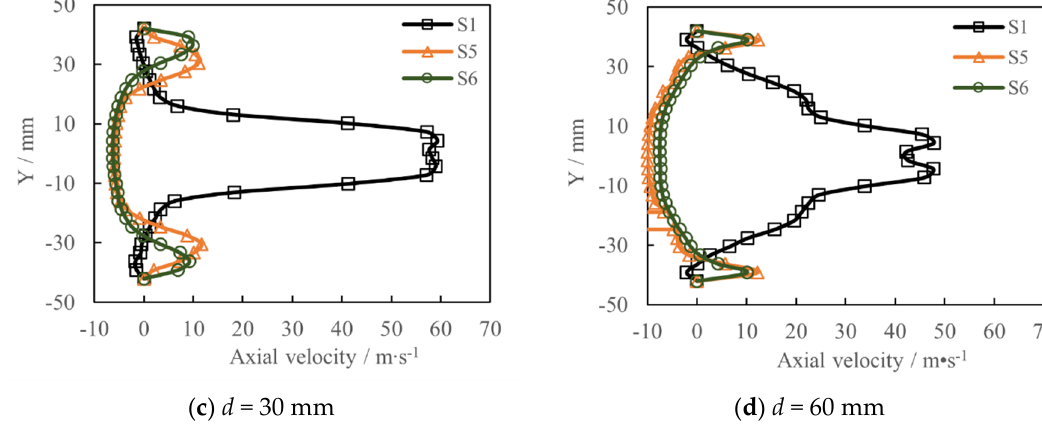
Figure 14. Radial profiles of axial velocity.